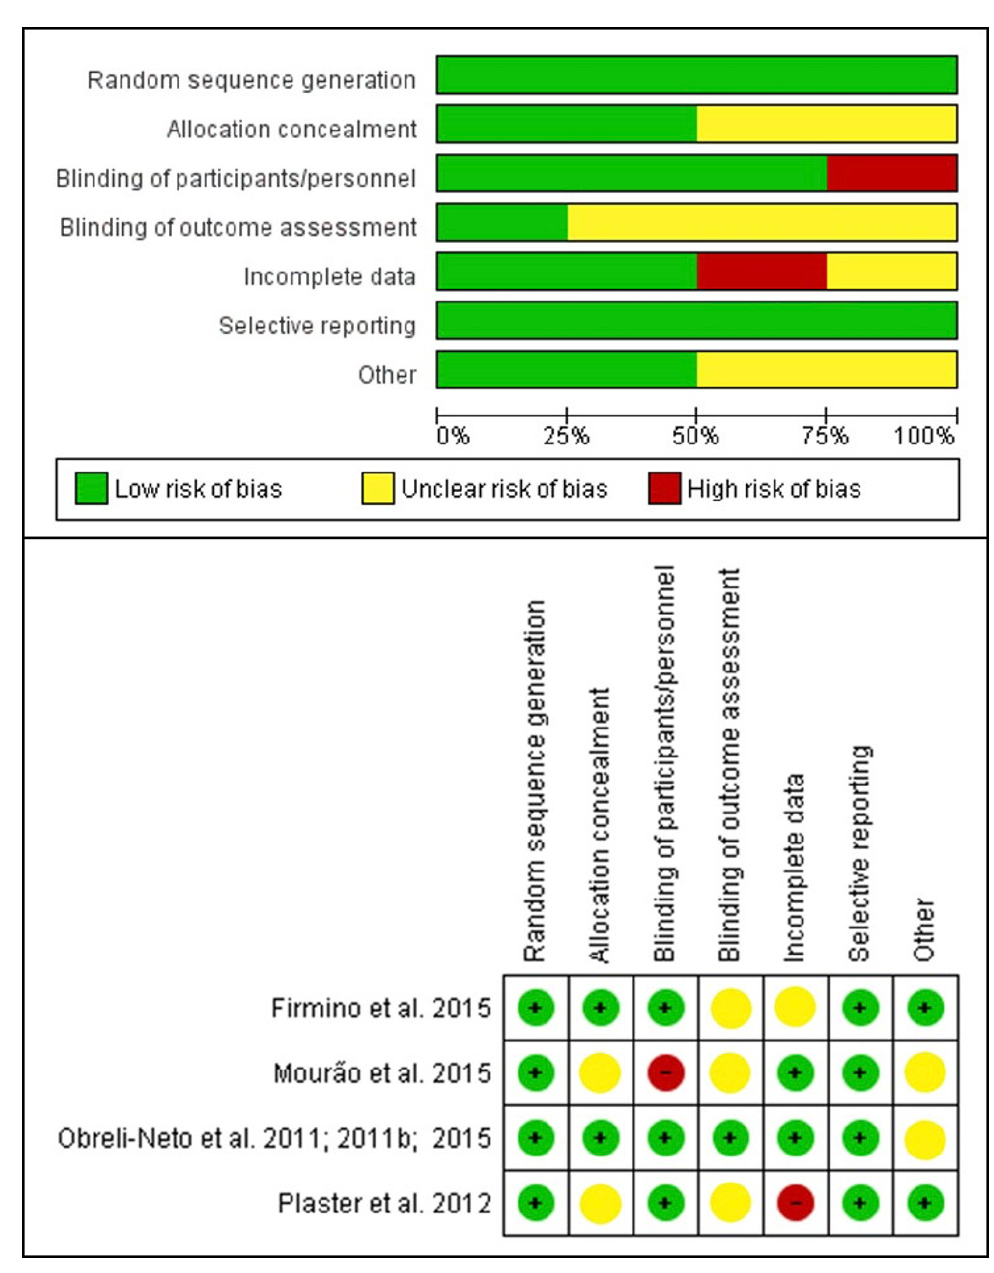
FIGURE 3 - Risk of bias of RCT studies as evaluated by